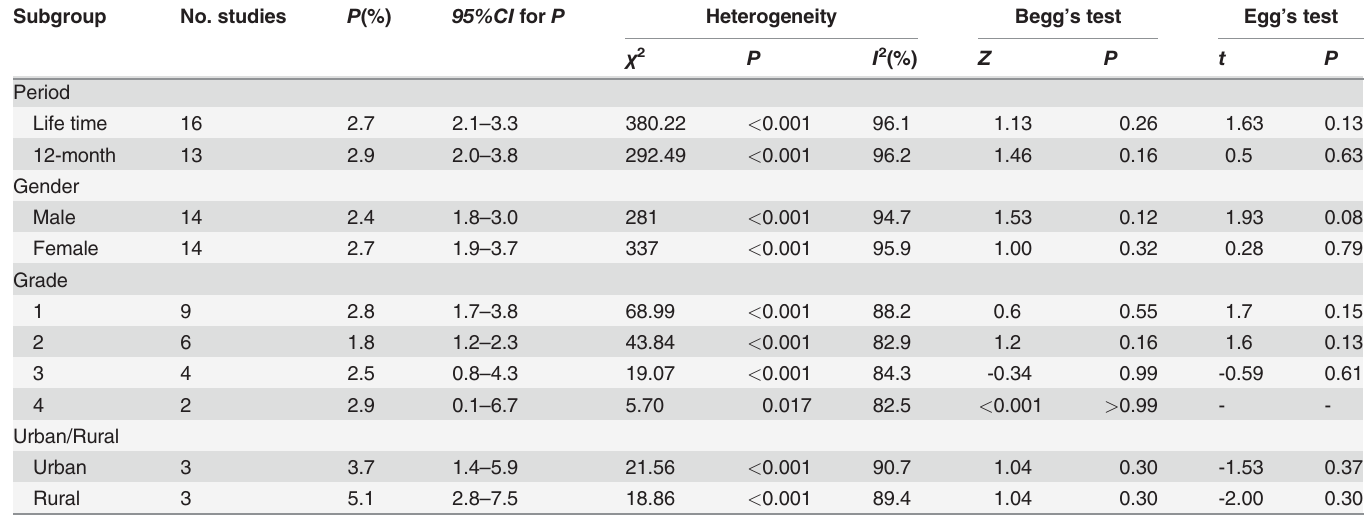
Table 2. The prevalence of suicide attempt in different subgroup of college students in China.